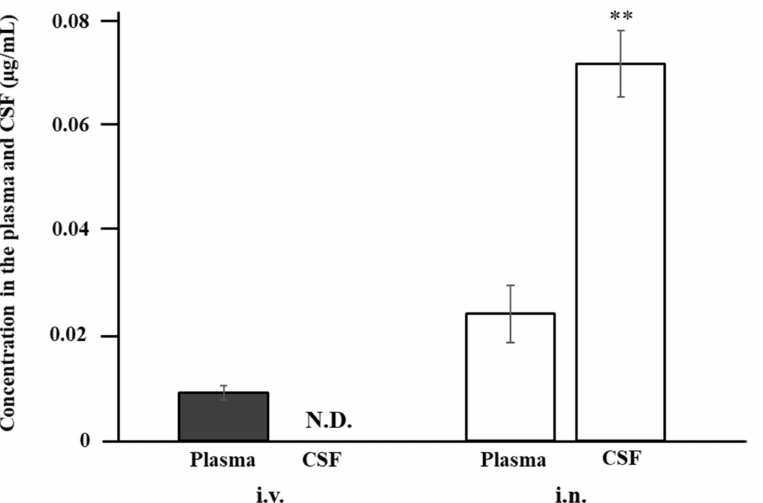
Figure 5. Concentrations of ANA-TA9 in the plasma and CSF 10 min after intranasal and intravenous application to rats. ** p < 0.01 vs. i.v. CSF Keys: (cid:4) : i.v. and (cid:3) : i.n. Welch’s t -test was used to assess the statistical significance. The results are expressed as the mean ± SE of three experiments. N.D.: not detected. Table 1. Pharmacokinetic parameters of ANA-TA9.